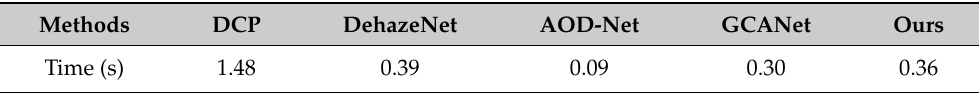
Table 6. Comparison of average model